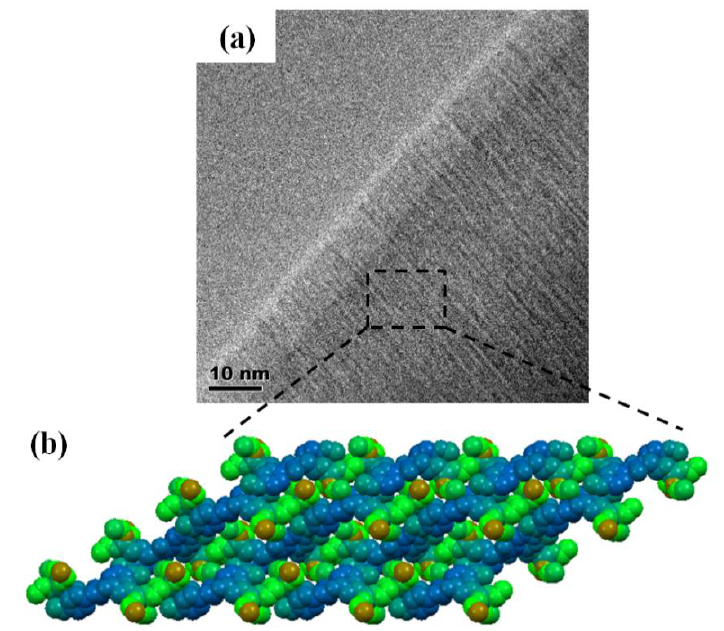
Figure 6. Progressive nanoscale self-organization of the hybrid membrane: ( a ) TEM image of the hybrid membrane M3; ( b ) the crystal packing of compound H2.